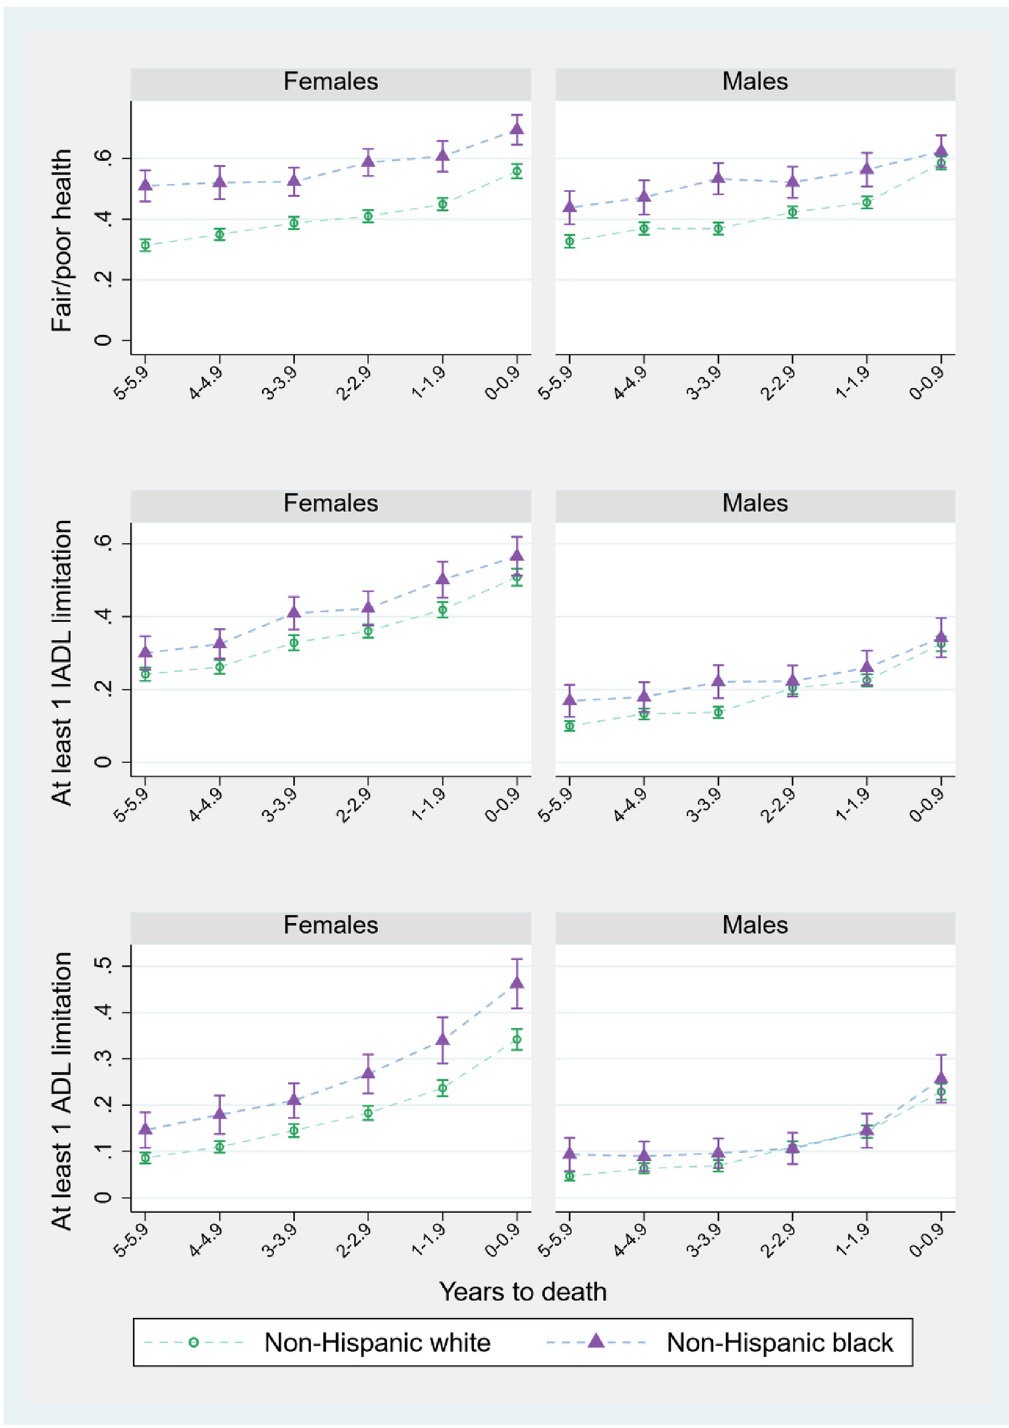
Fig 3. Proportion of population in given health state across final years of life, by race (with 95% confidence intervals).